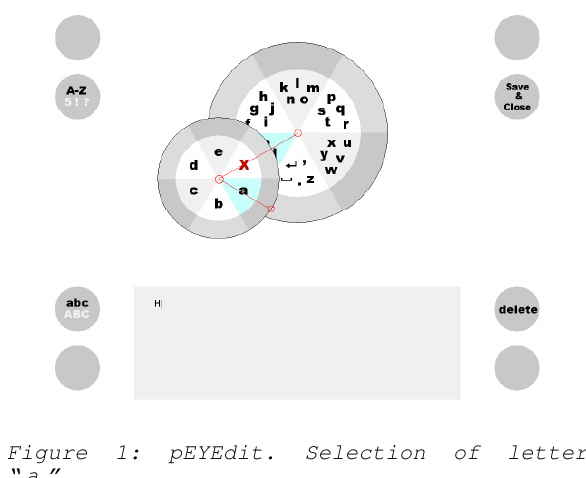
Figure 1: pEYEdit. Selection of letter “ a ”